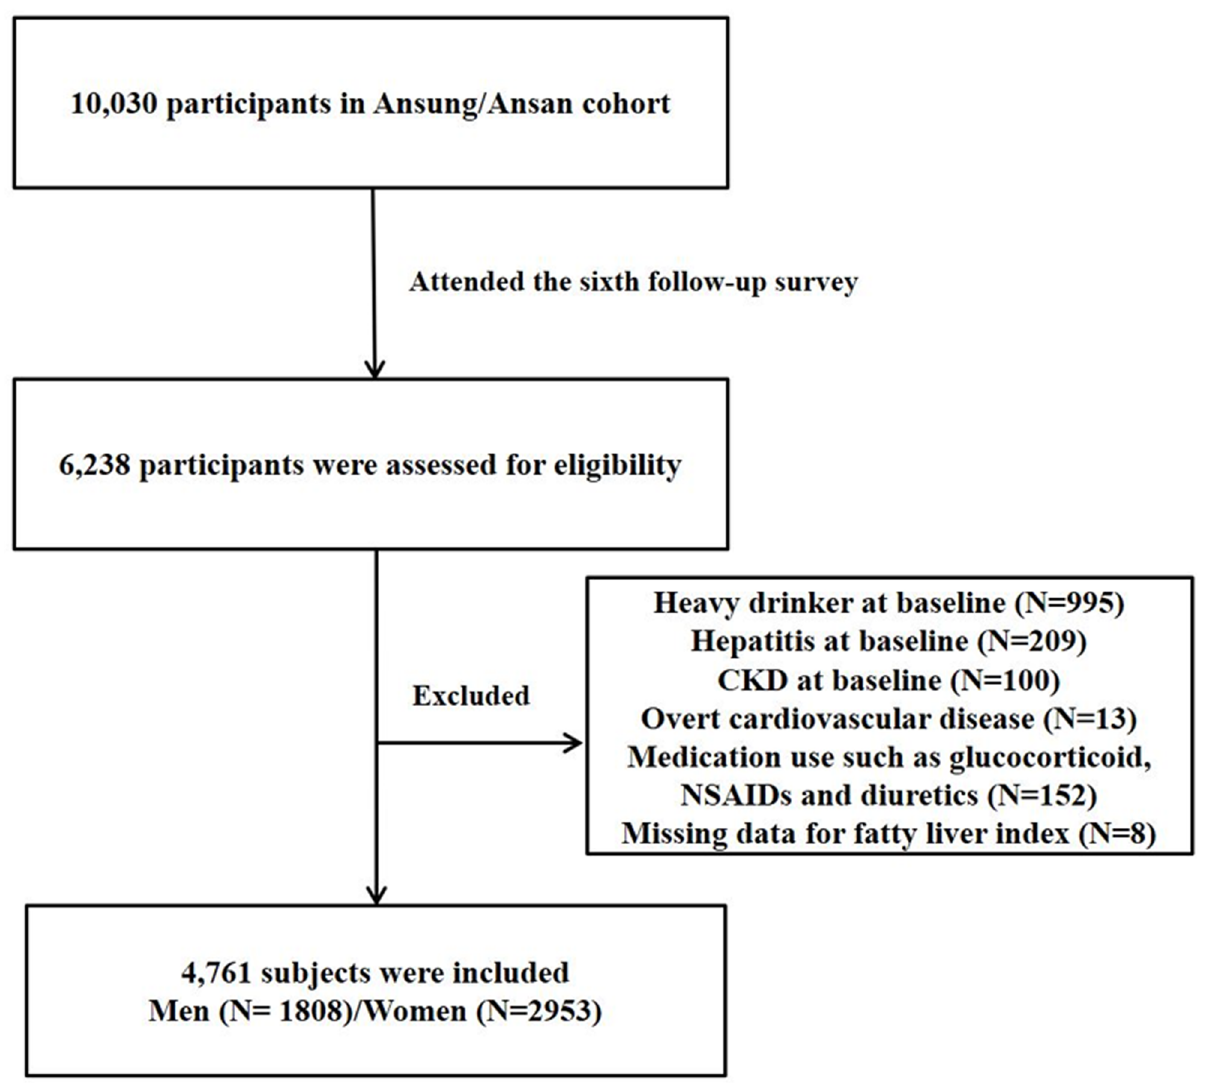
Fig 1. Study populations. CKD, chronic kidney disease;NSAIDs, nonsteroidal anti-inflammatory drugs.